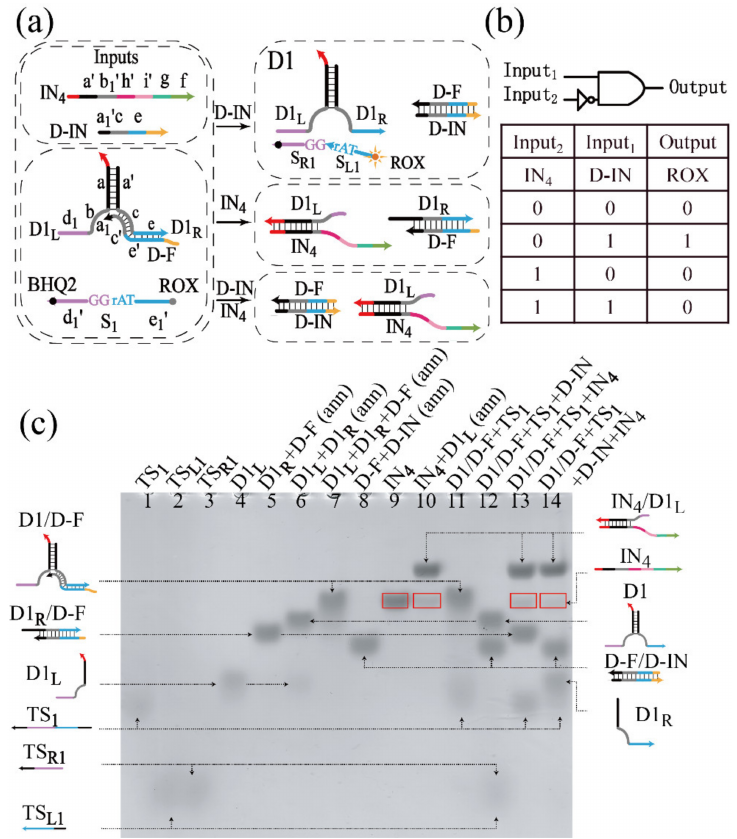
Figure 1. ( a ) Schematic diagram of the INH gate. ( b ) Truth table and logical operations of INH gate. ( c ) PAGE gel of the INH gate. The DNA strands and operations are marked above the lane number. Lane 1, substrate TS 1 ; lane 2, DNA strand TS L1 ; lane 3, DNA strand TS R1 ; lane 4, DNA strand D1 L ; lane 5, the annealing of the mixture of D1 L and D-F; lane 6, annealing operations for the mixture